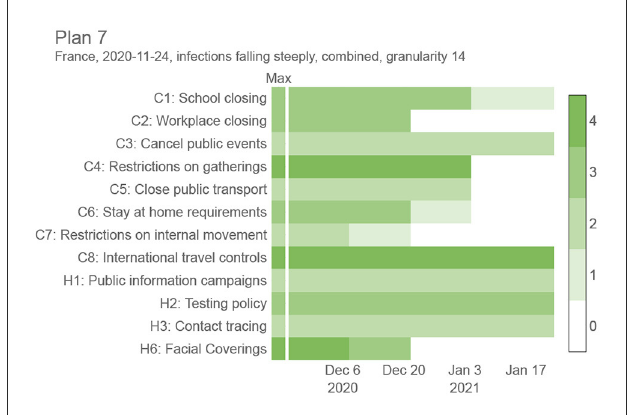
FIGURE1 Sample intervention plan for France between November 24, 2020, and January 24, 2021, with a granularity value of 14 days. Refer to Figure 6 to see how this plan compares against other proposed plans in the same